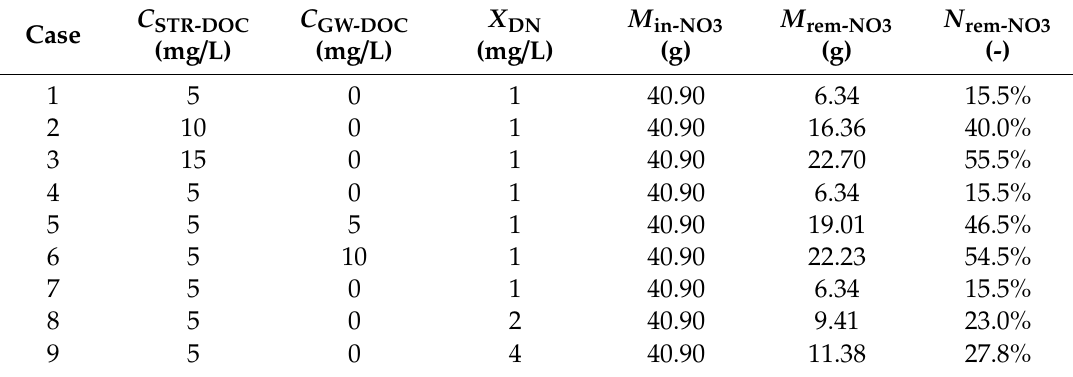
Table 4. M in-NO3 , M rem-NO3 and N rem-NO3 under di ff erent biochemical